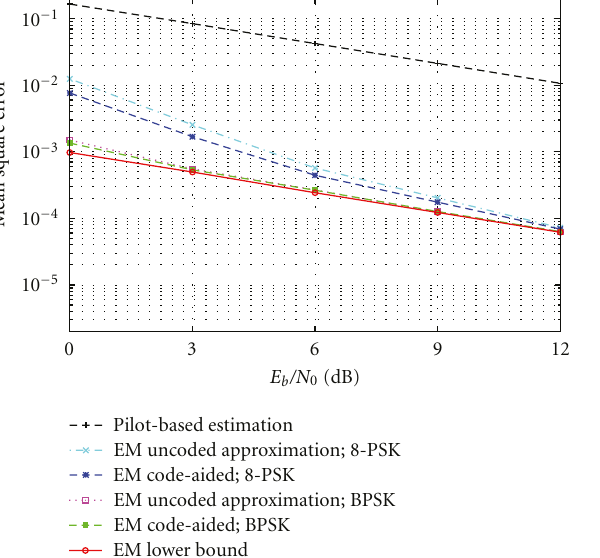
Figure 6: Mean Square Error values for the estimate of h 2 .